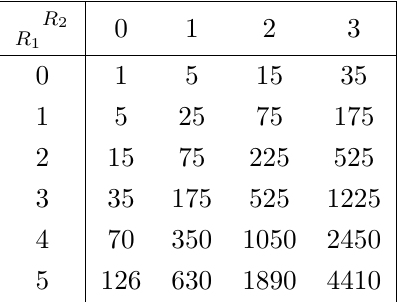
. . . q µ r q ν 1 . . . q ν s symmetrised in the q 1 and 1 1 2 2